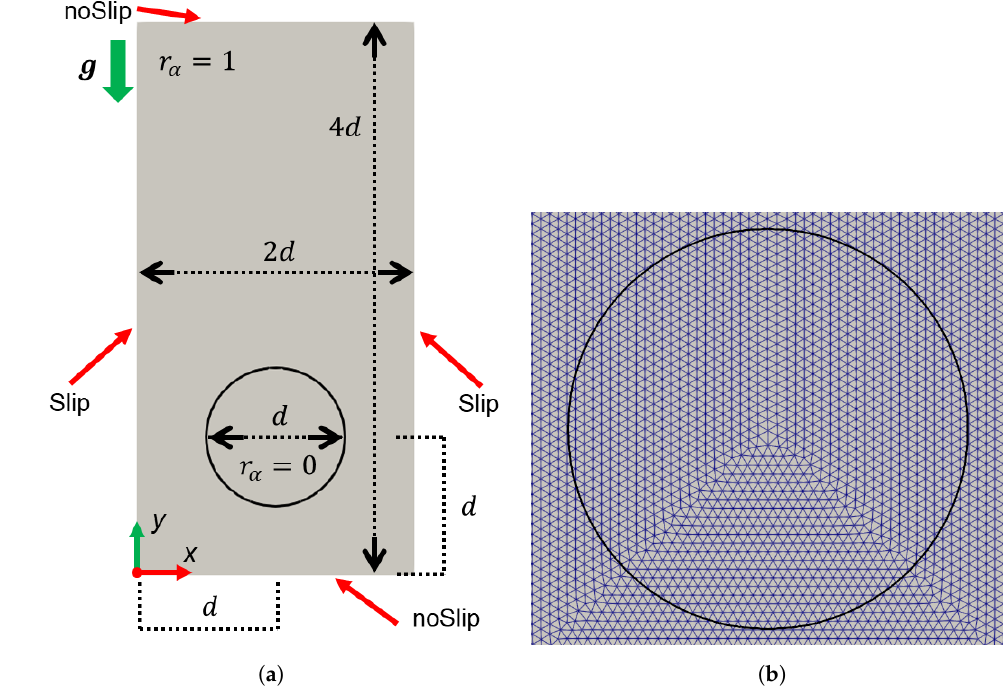
Figure 3. Computational domain, BCs, ICs ( a ) and mesh detail on the bubble at t = 0 ( b ) for the 2D rising bubble test. The black line in ( b ) is the r α = 0.5